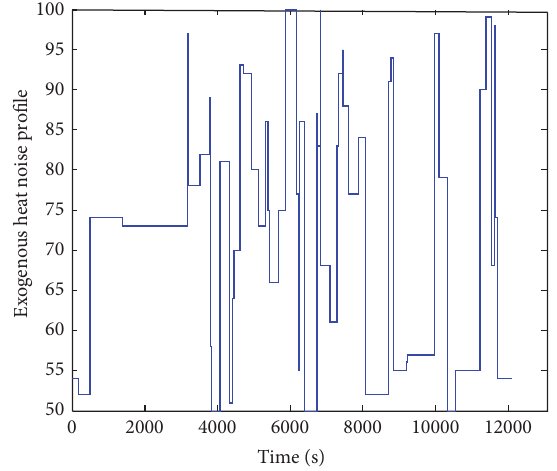
Figure 13: Exogenous heat noise profile.